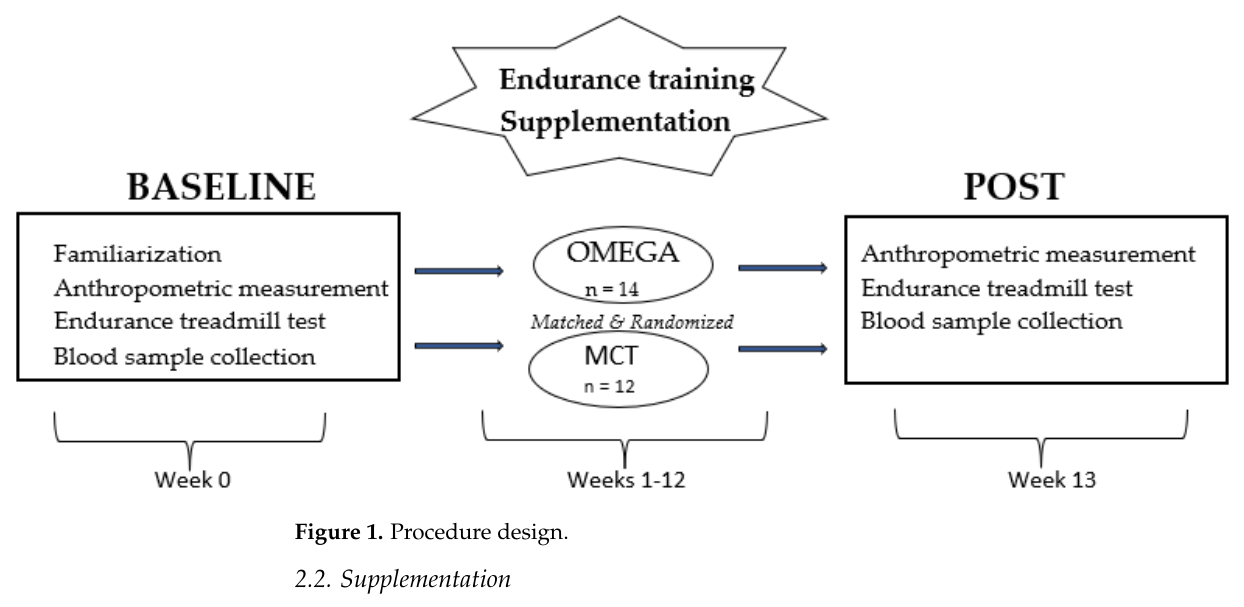
Figure 1. Procedure design.